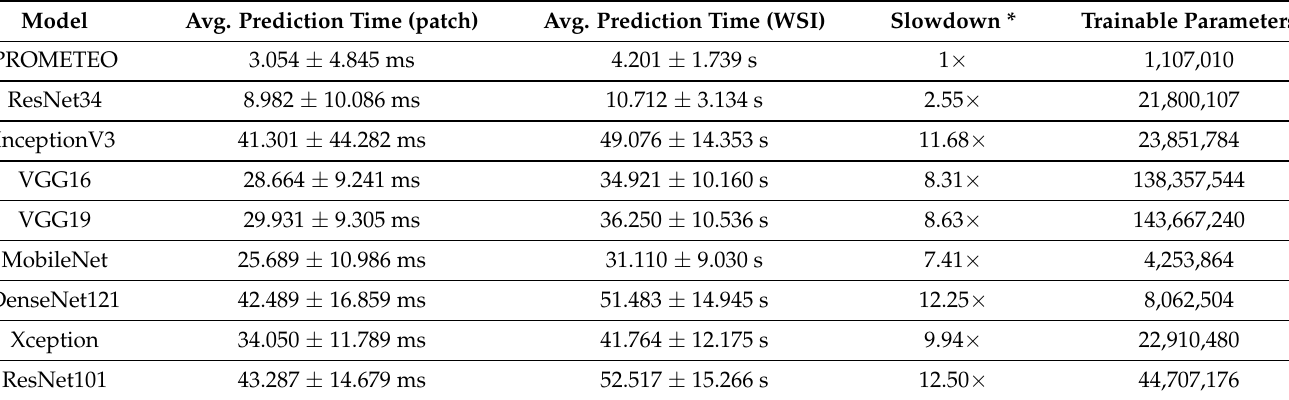
Table 2. Average patch and WSI prediction time, slowdown and number of trainable parameters for each of the CNN architectures considered in this